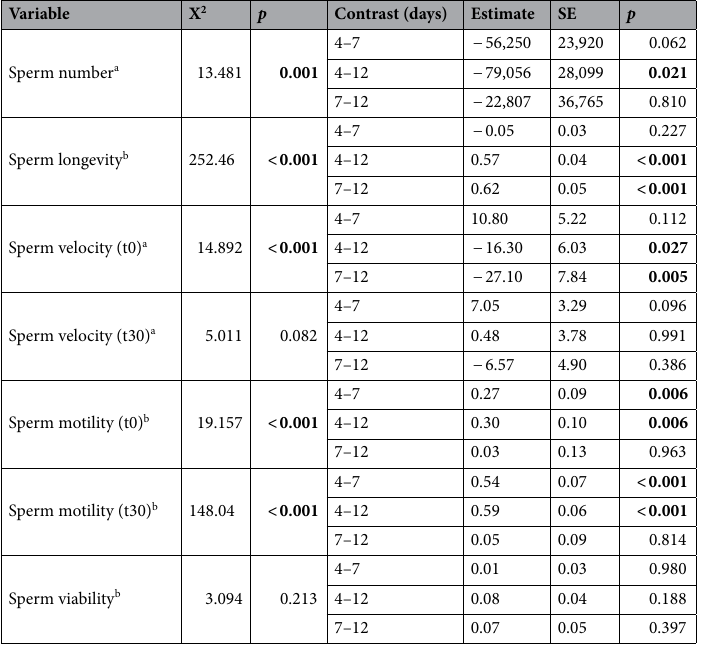
Table 1. Statistical analysis: effects of sperm storage duration on zebrafish sperm traits. Results from linear (a) and general (b) mixed effects models and their associated post-hoc analysis. The analyses were performed on N = 58 samples for sperm viability and on N = 70 samples for all the other variables. p values of pairwise differences between the three experimental conditions (sperm storage duration: 4, 7, 12 days) are obtained with the Tukey method adjusted for multiple comparisons. Terms in bold are statistically significant ( p <